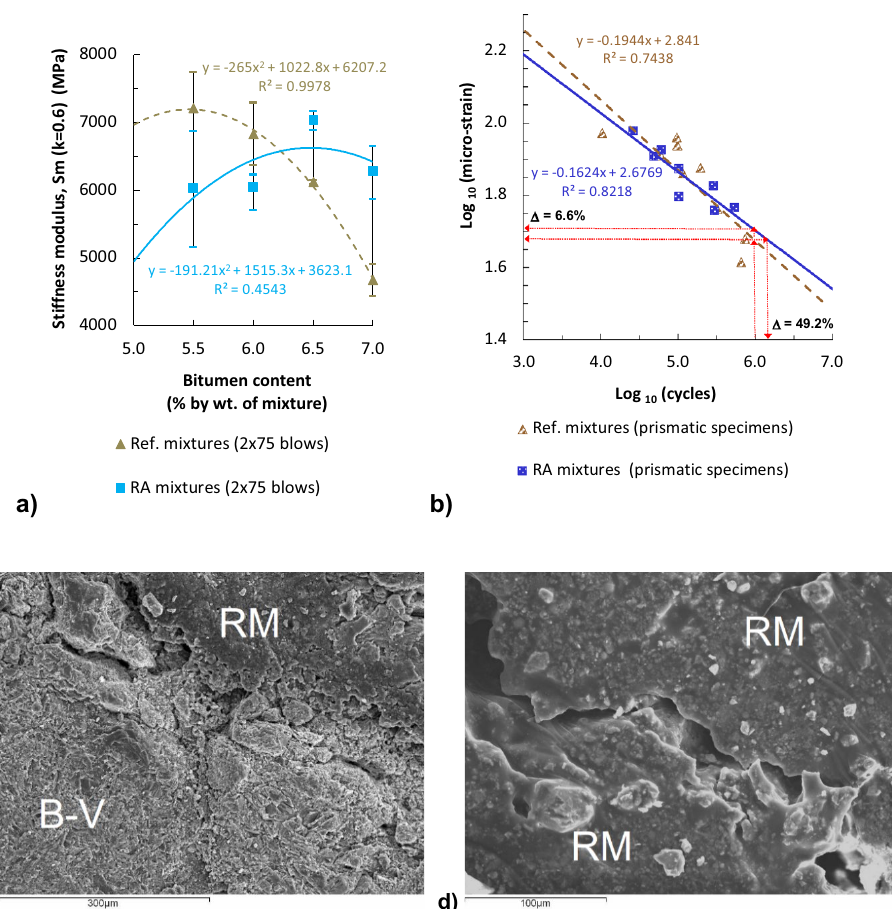
Figure 7. Dynamic mechanical properties: ( a ) stiffness modulus by IT-CY tests (EN 12697-26); ( b ) fatigue laws by 4PB-PR tests (EN 12697-24) with a bitumen content of 6% (by total wt. of mixture); ( c ) fatigue micro-crack at the interfacial contact between the volcanic aggregate particle (B–V) and the mastic of rubberized binder (RM) [magnification ×200]; ( d ) fatigue micro-crack in the RM [magnification